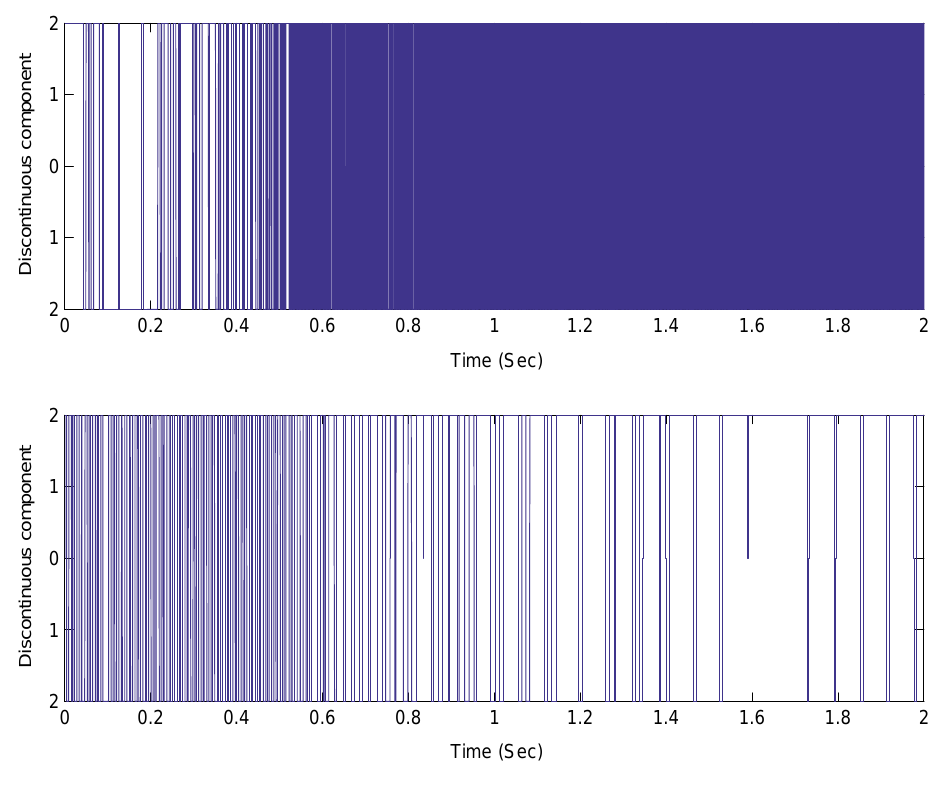
Fig. 8. Discontinuous switching components of sliding mode